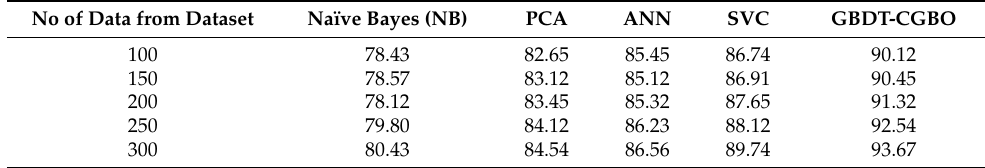
Figure 4. F-Score Analysis of GBDT-CGBO method with existing system. Table 3. F-Score Analysis of GBDT-CGBO method with existing system in